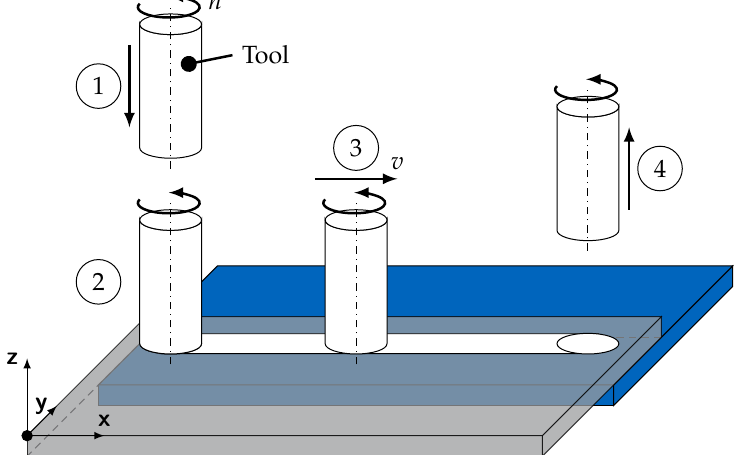
Figure 1. Process sequence of FPJ (blue, thermoplastic material; gray, aluminum), according to Meyer et al.